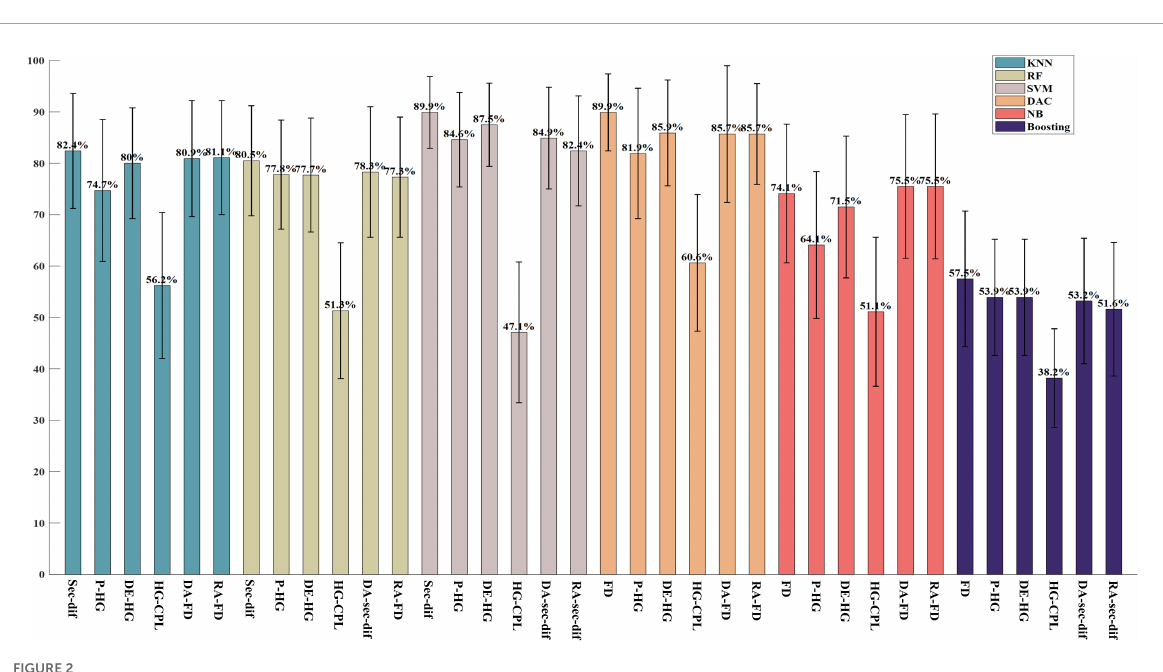
Le of the coherence network were selected to visualize by t-SNE (Donahue et al., 2013). Figures 4 , 5 show the feature distribution maps of the ESD and DEAP dataset. The feature